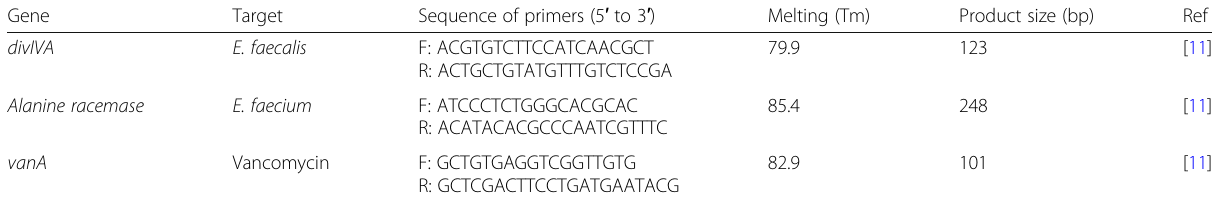
Table 1 Oligonucleotide sequences used in this study Gene Target Sequence of primers (5 ′ to 3 ′ ) Melting (Tm) Product size (bp) divIVA E. faecalis Alanine racemase E.